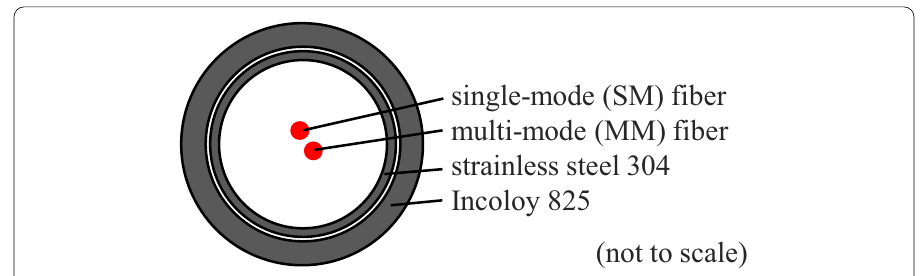
Fig. 4 Fiber optic cable